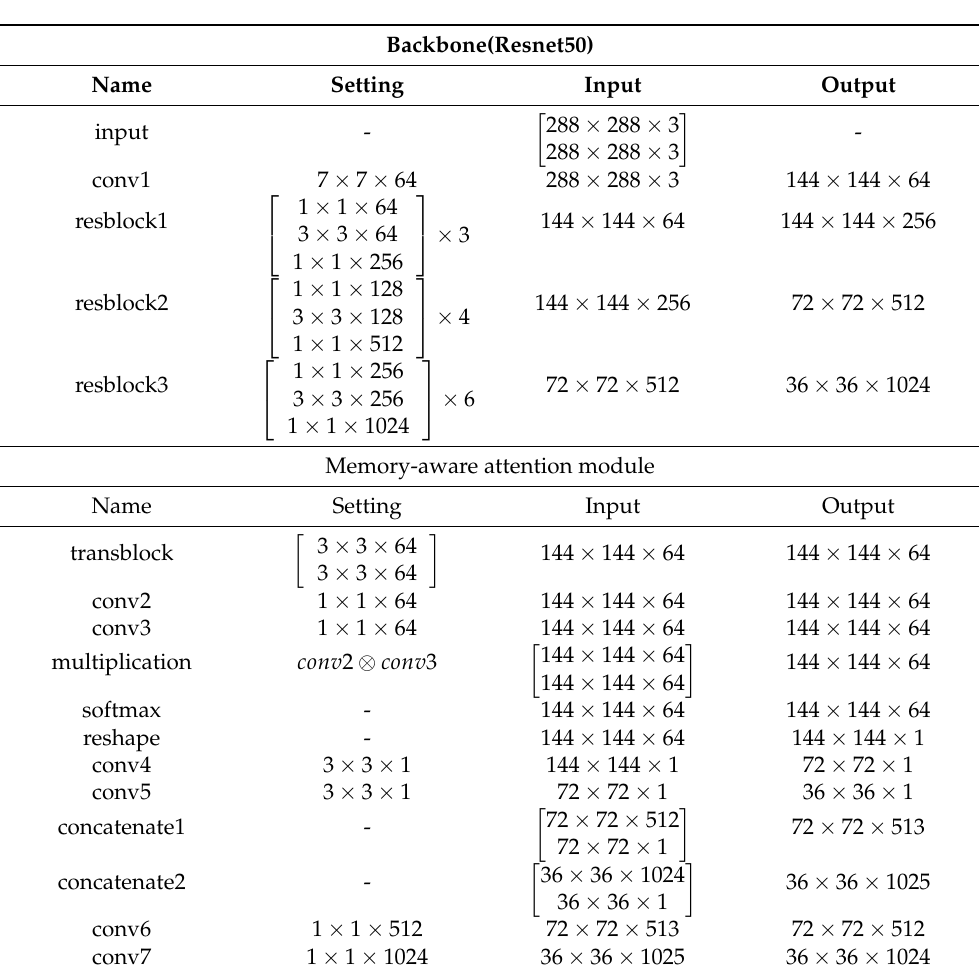
Table 2. The detailed architecture of our